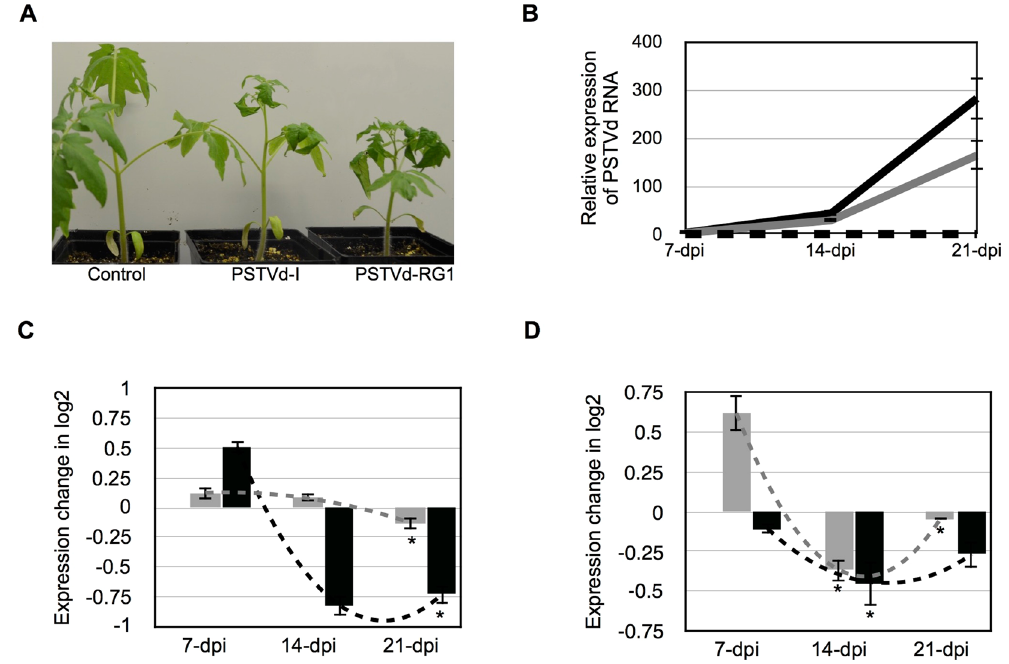
Figure 3. Effect of the PSTVd variants on the predicted target mRNAs. ( A ) Both the PSTVd-I and PSTVd-RG1 variants were inoculated into tomato plants. At 14-dpi, the plants inoculated with both of the PSTVd variants showed disease symptoms when compared to mock inoculated plants. ( B ) Total RNA extracted from tomato plants at 7, 14 and 21-dpi were used to monitor the PSTVd titer. In the graph, the dotted black line (on the X-axis) represents mock inoculated plants, while the grey and black solid lines indicate the PSTVd-I and PSTVd-RG1 inoculated plants, respectively. The effects of the PSTVd variants on the levels of the ( C ) chloride channel protein CLC-b-like and ( D ) the RPS3a-like mRNAs were evaluated at different time intervals. The expression change is presented on a log 2 scale. Each experiment was performed at least three times with true biological replicates. The changes in the expression levels of the mRNAs between the time points are shown with dotted lines. The error bars indicate SD. The asterisks indicate statistically significant for paired t- test ( P <